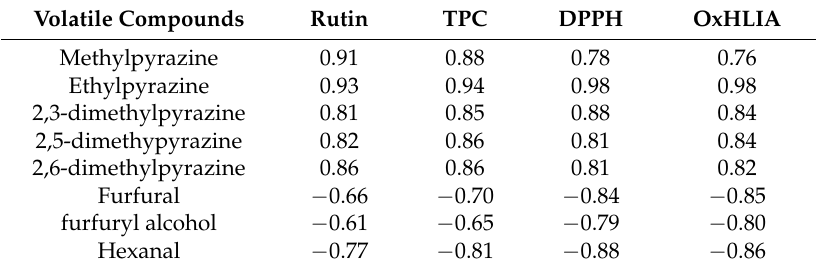
Table 4. Correlation between the rutin, TPC contents, antioxidant capacity (measured by DPPH and OxHLIA assays) with volatile compounds contents in rye-buckwheat biscuits. Volatile Compounds Rutin TPC DPPH OxHLIA Methylpyrazine 0.91 0.88 0.78 0.76 Ethylpyrazine 0.93 0.94 0.98 0.98 2,3-dimethylpyrazine 0.81 0.85 0.88 0.84 2,5-dimethypyrazine 0.82 0.86 0.81 0.84 2,6-dimethylpyrazine 0.86 0.86 0.81 0.82 Furfural − 0.66 − 0.70 − 0.84 − 0.85 furfuryl alcohol − 0.61 − 0.65 − 0.79 − 0.80 Hexanal − 0.77 − 0.81 − 0.88 −